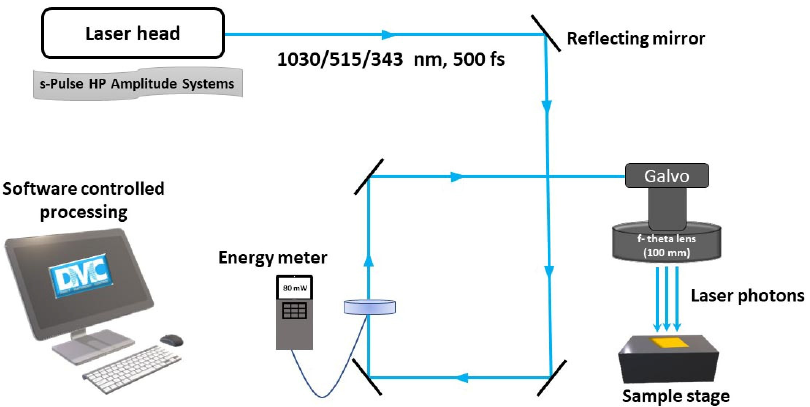
Figure 1. The schematic diagram of the laser setup used for the crystallization experiment.